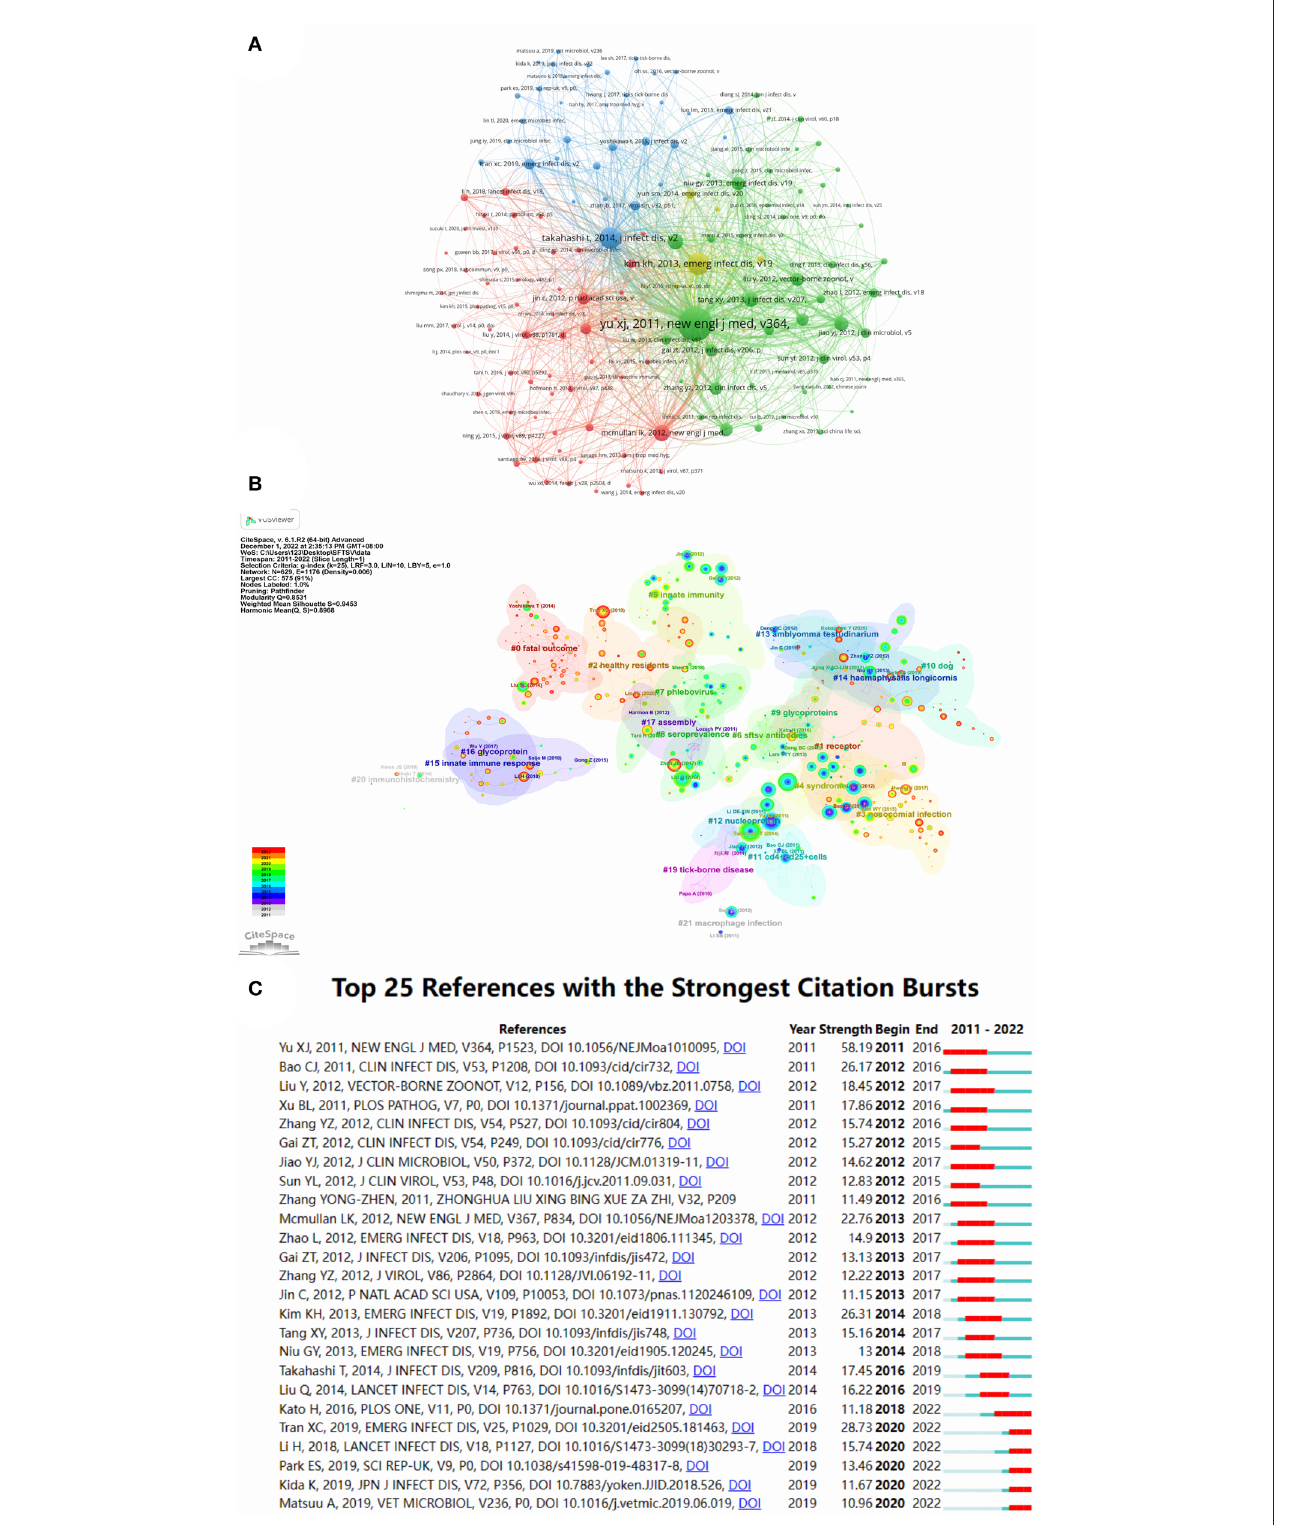
FIGURE6 Visualization map of reference on SFTSV. (A) Distribution of 148 reference with a frequency of no less than 20 times. (B) Reference co-citation network for clustering title terms. (C) Top 25 references with the strongest citation